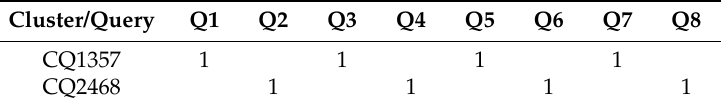
Table 8. Final distribution of queries on clusters.